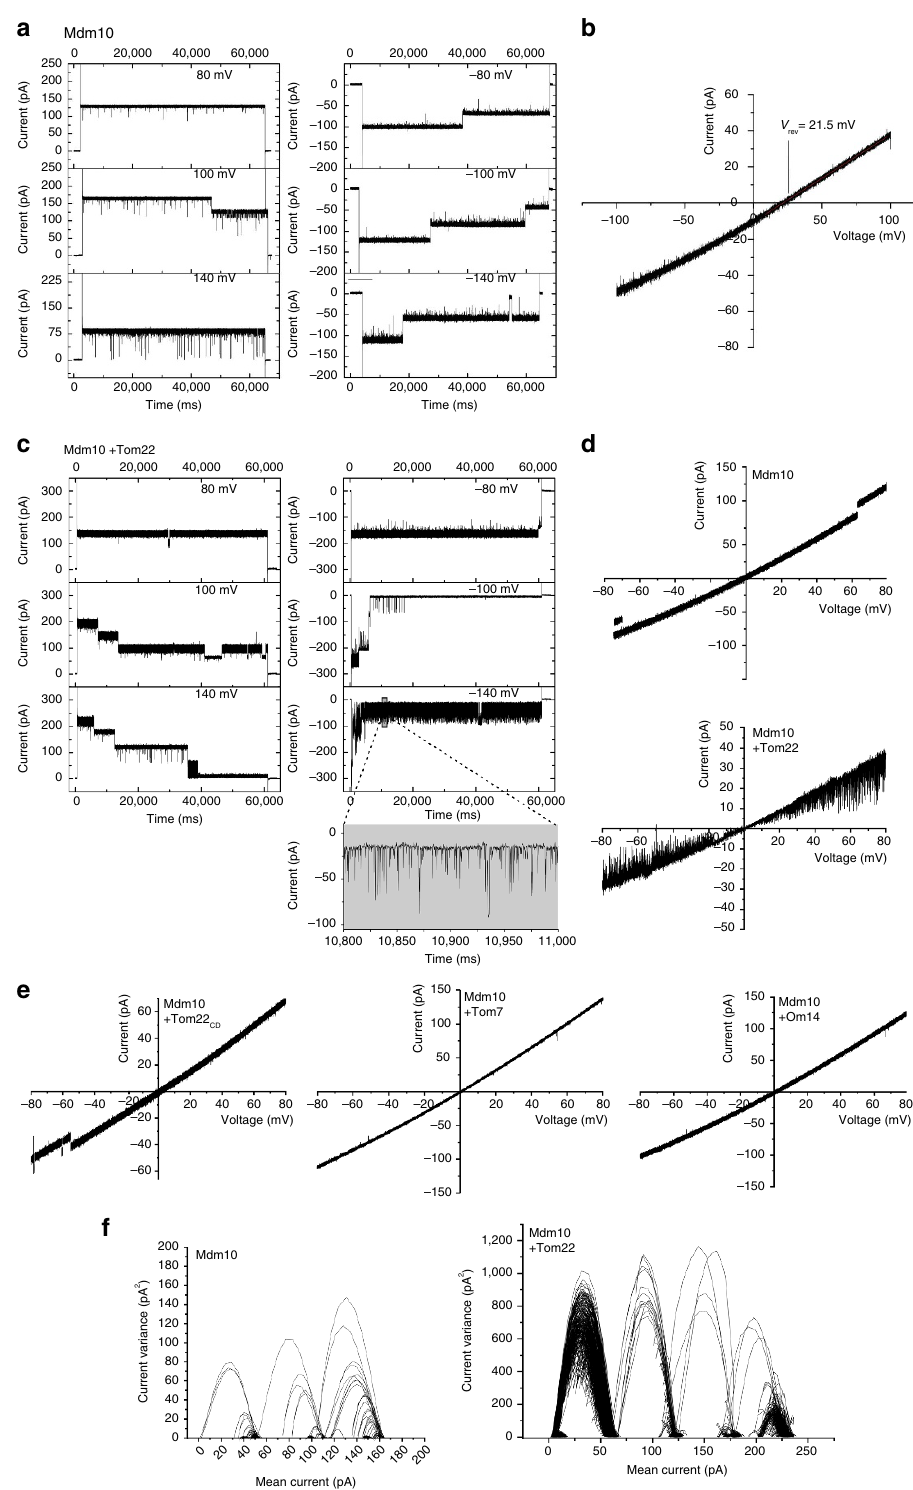
Figure 6 | Mdm10 forms a Tom22-sensitive channel. ( a ) Single-channel recording under symmetrical buffer conditions (250mM KCl and 10mM MOPS-Tris, pH 7.0) at the indicated V m from a planar lipid bilayer after a single fusion event of Mdm10 proteoliposomes. ( b ) Current–voltage relationship of Mdm10 (main conductance) in asymmetric buffer conditions (250/20mM KCl ( cis / trans ) and 10mM MOPS-Tris, pH 7.0). ( c ) Single-channel recording of Mdm10 under symmetrical buffer conditions as described in a after preincubation of Mdm10 proteoliposomes with full-length Tom22 precursor. ( d ) Current–voltage relationship of Mdm10 (main conductance) under symmetrical buffer conditions (upper panel). Mdm10 proteoliposomes were additionally preincubated with Tom22 (lower panel). ( e ) Current–voltage relationship of Mdm10 (main conductance) under symmetrical buffer conditions after preincubation of Mdm10 proteoliposomes with the cytosolic domain of Tom22 (Tom22 CD ), Tom7 or Om14. ( f ) Mean-variance plot from a current recording at V m ¼ 100mVof Mdm10 under symmetrical buffer conditions (left panel). Mdm10 proteoliposomes were additionally preincubated with Tom22 (right